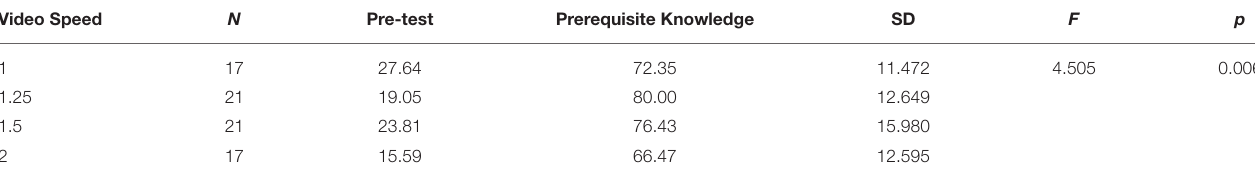
TABLE 2 | Influence of video speed on learning effect shown by covariance analysis. Video